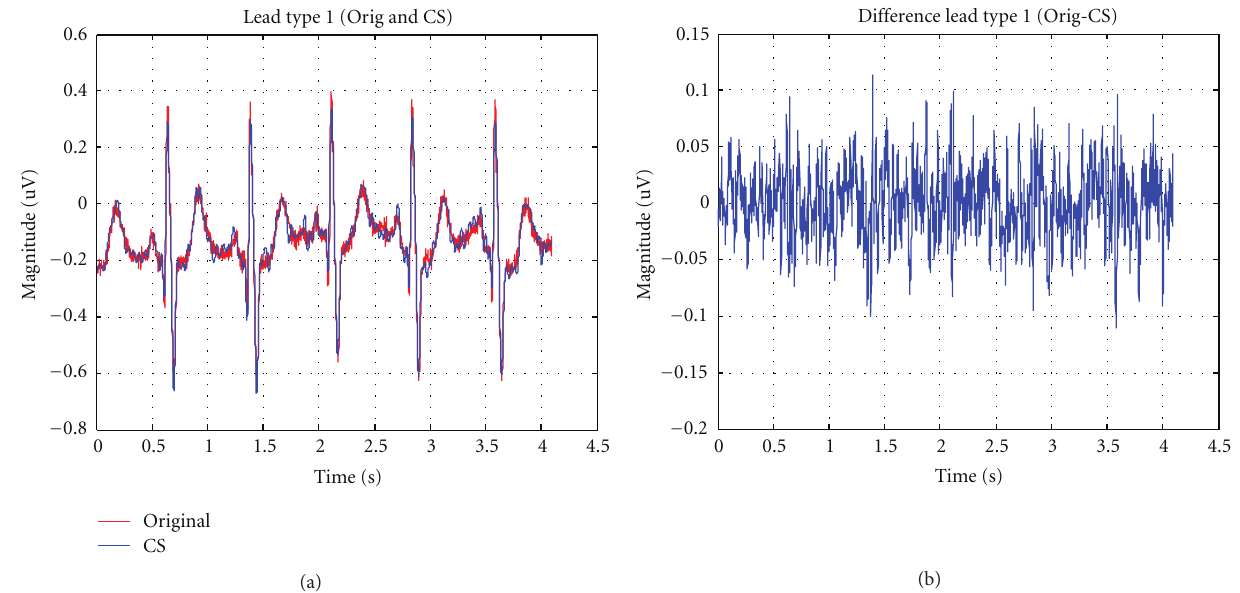
Figure 7: Comparison between the original data and the CS recovering. Figure 7(a) shows lead type 1 at V1, original in blue and the CS in red, where their difference is depicted in Figure 7(b). The difference is less than 0.08 uV.